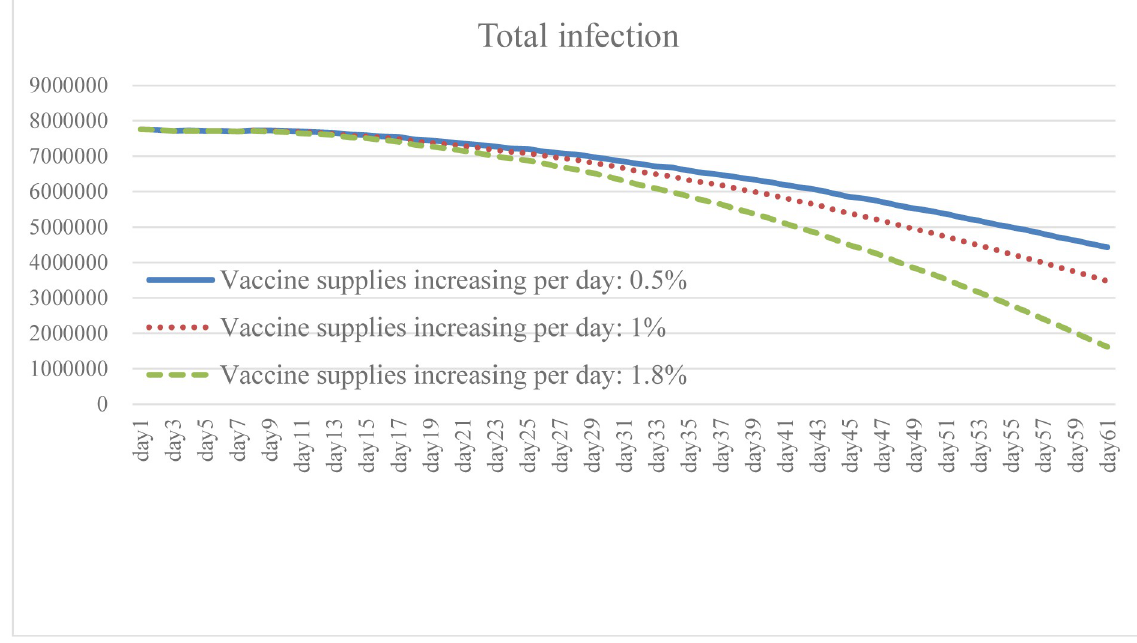
Fig 10. Total infection under different vaccine supply.